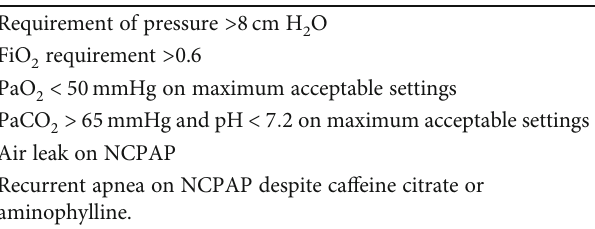
Table 4: Failure criteria for